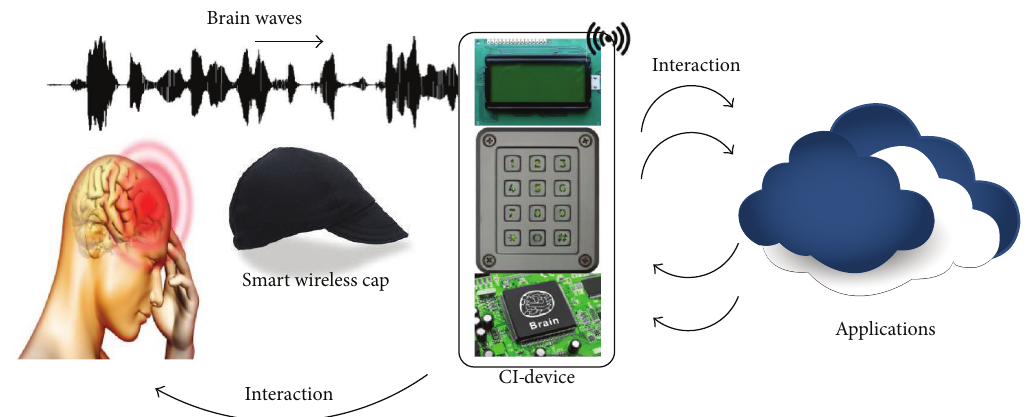
Figure 1: CI-device interacting with an elderly individual and external